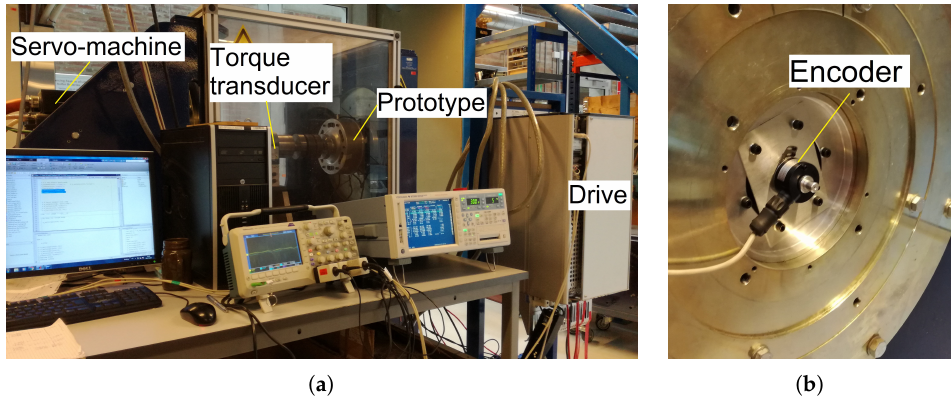
Figure 28. Test set-up as motor; ( a ) drive end, ( b ) non-drive end.